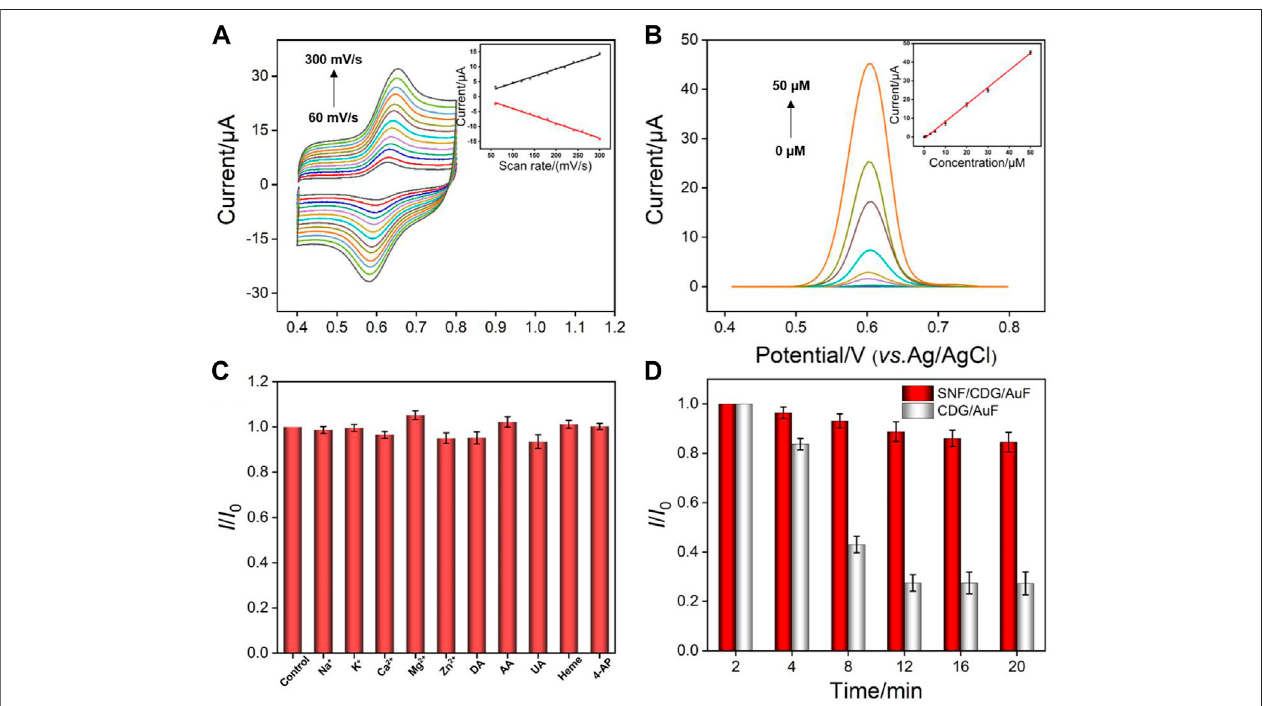
FIGURE 6 | (A) CV curves on SNF/CDG/AuF for APAP (20 μ M) at different scan rates after accumulation for 150 in PBS (0.1 M, pH 3.0). The inset shows the dependence of anodic and cathodic peak currents on the scan rate. (B) DPV curves on SNF/CDG/AuF with various concentrations of APAP. The inset shows the calibration curve. (C) Effect of interfering species on the anodic peak currents of APAP (5 μ M) at the SNF/CDG/AuF electrode in PBS (0.1 M, pH 3.0). I 0 and I depict the anodicpeakcurrentsmeasuredintheabsenceandpresenceofinterferingspecies(0.1 mM).Errorbarsdenotethestandarddeviationsofthreemeasurements. (D) Anti-fouling performance of SNF/CDG/AuF and CDG/AuF in the paracetamol tablet matrix. I 0 and I represent the anodic peak currents of APAP (20 μ M) in continuous determination in different